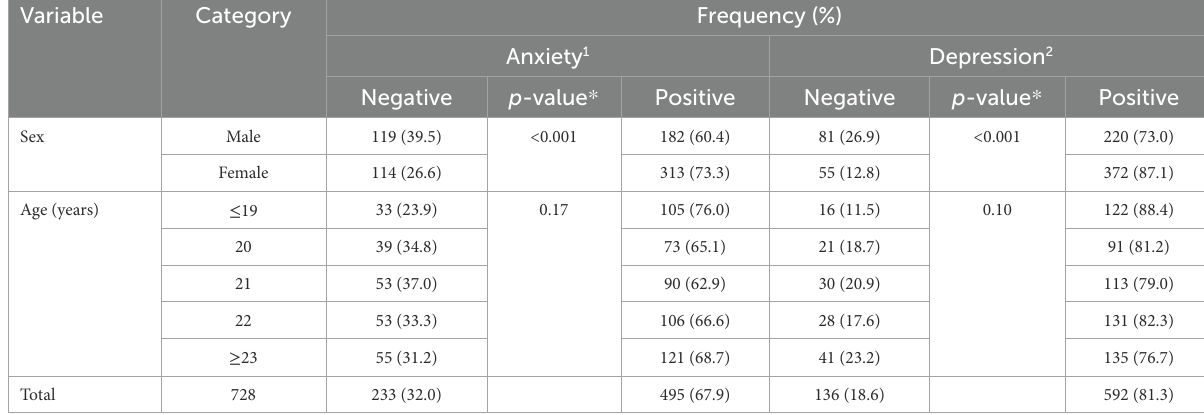
TABLE 2 Prevalence of anxiety and depression according to the Goldberg scale by sex and age among medical students at the Autonomous University of Zacatecas, 2021.